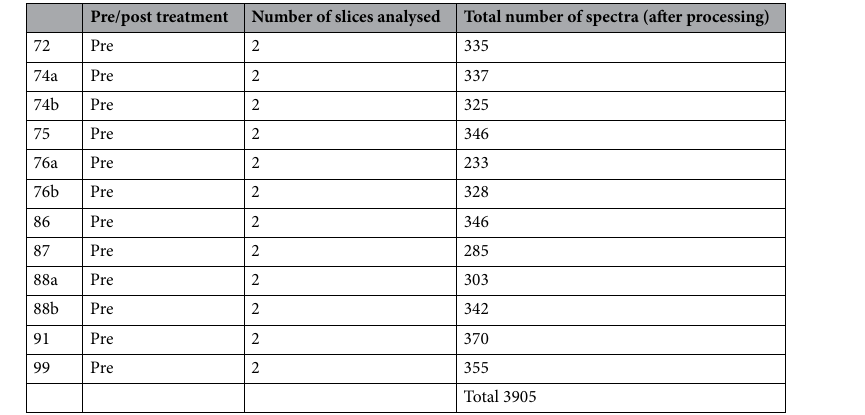
Table 6. Summary of RS data acquired from each